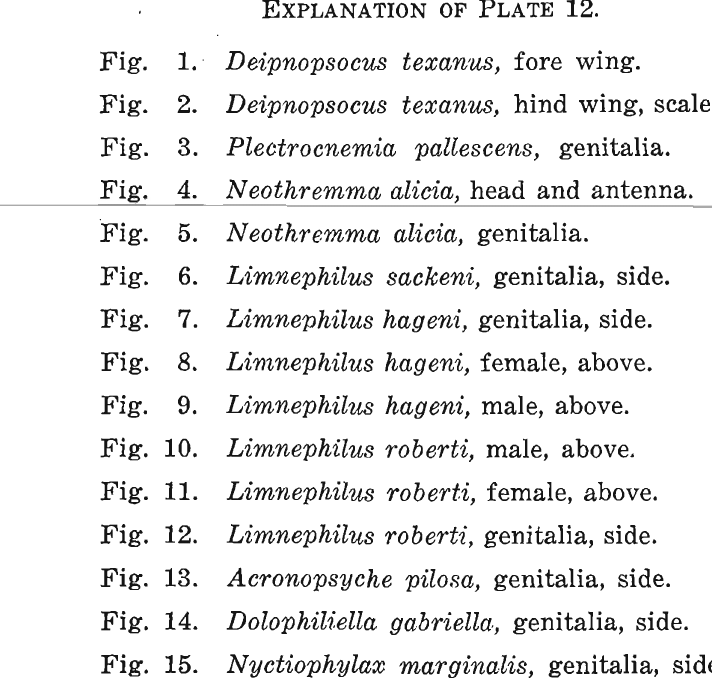
Fig. 1. Deipnopsocus texanus, fore wing. Fig. 2. Deipnopsocus texanus, hind wing, scales. Fig. 3. Plectrocnemia pallescens, genitalia. Fig. 4. Neothrenznza alicia, head and antenna. Fig. 5. Neothremma alicia, genitalia. Fig. 6. Fig. 7. Fig. 8. Fig. 9. Fig. 10. Fig. 11. Fig. 12. Fig. 13. Fig. 14. Fig.